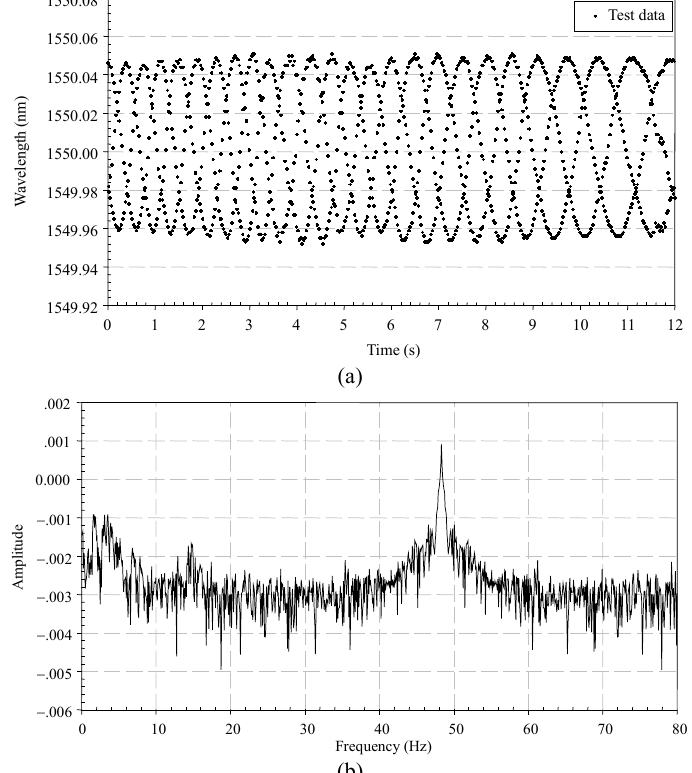
Fig. 6 Test data and FFT analysis with the vibration source at 50 Hz: (a) test data and (b) FFT spectral curve after